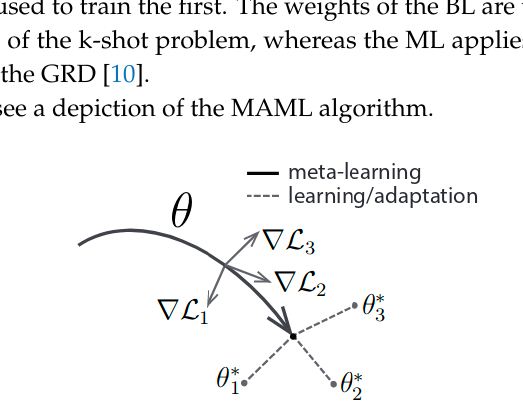
Figure 1. Model-Agnostic Meta-Learning algorithm.